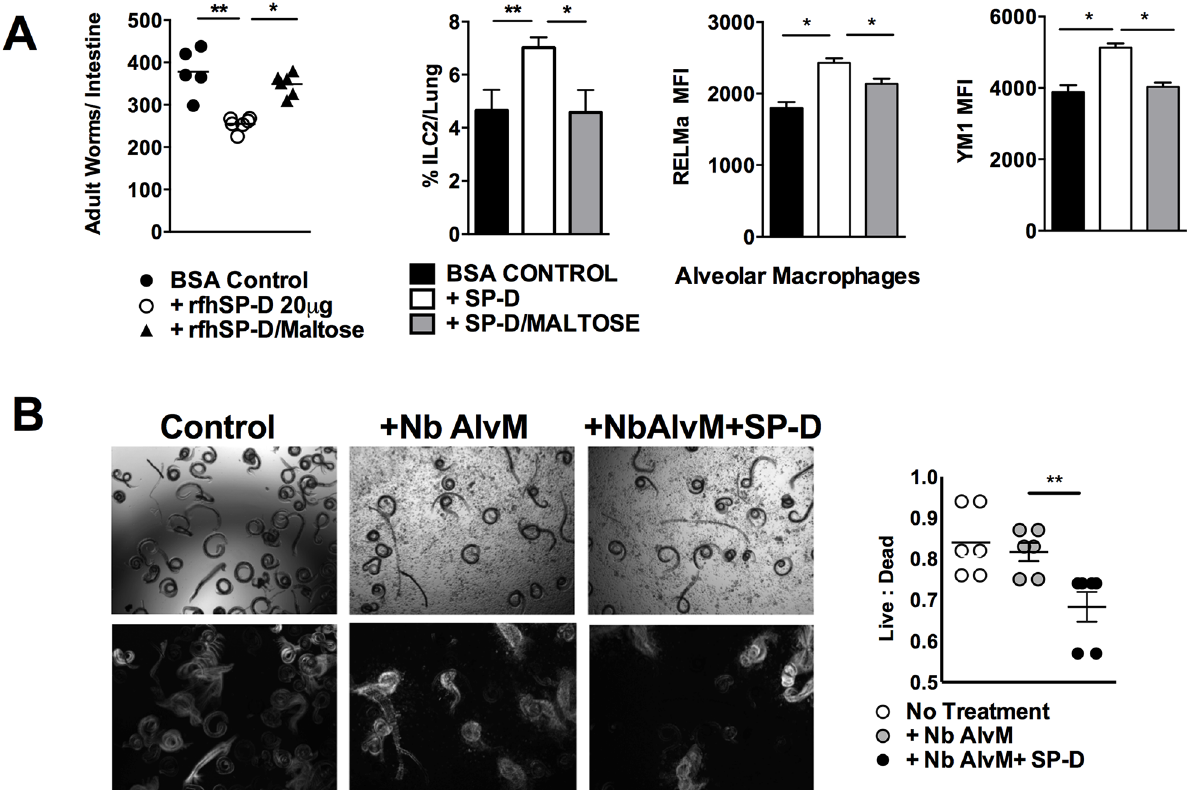
Fig 6. SP-D-mediated protection against N . brasiliensis infection requires carbohydrate recognition domain binding to opsonise L4 for enhanced macrophage killing. Mice were treated with BSA, rfhSP-D or maltose bound rfhSP-D. Intestinal worm burdens were quantified at day 5 PI, and alveolar cell populations were determined at day 5 PI ( a ). Untreated N . brasiliensis L4 or N . brasiliensis L4 pre-incubated with 20 μ g/ml SP-D were cultured without or with alveolar macrophages (isolated from day 7 N . brasiliensis infected mice) for 48 hrs in serum free media and analysed by microscopy for viability ( b ). Top row shows bright field, bottom row shows standard deviation of overlay of 20 sequence pictures; white indicates movement. Data are representative of two individual experiments. N = 5 mice per group. * P < 0.05, ** P < 0.01.